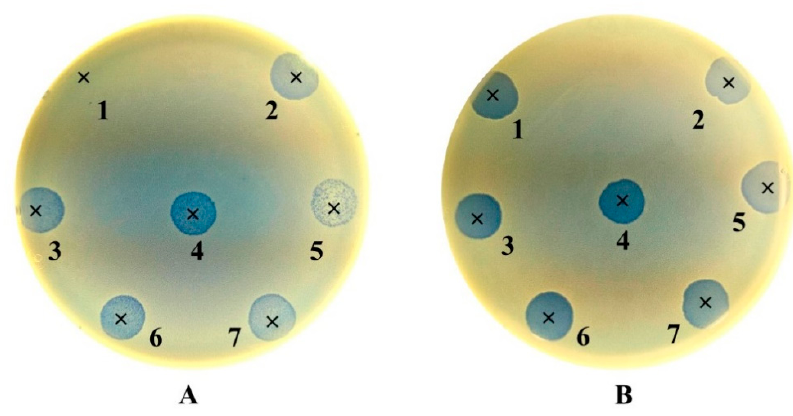
Figure 2. Lytic activity of seven commercial bacteriophage cocktails against Staphylococcus